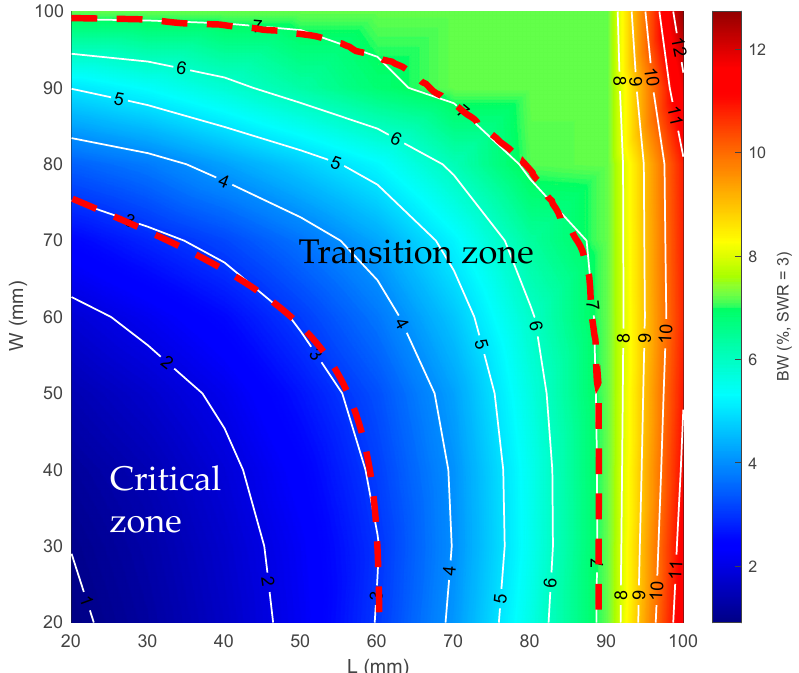
Figure 9. Potential bandwidth for several ground planes. The critical area is defined as cases with less than 3% potential bandwidth. A transition zone is defined as having a potential bandwidth larger than 3% and smaller than 7.2%. In this area, a broadband matching network (three or more lumped components) could achieve the 7.2% to cover the 863–928 MHz frequency band.